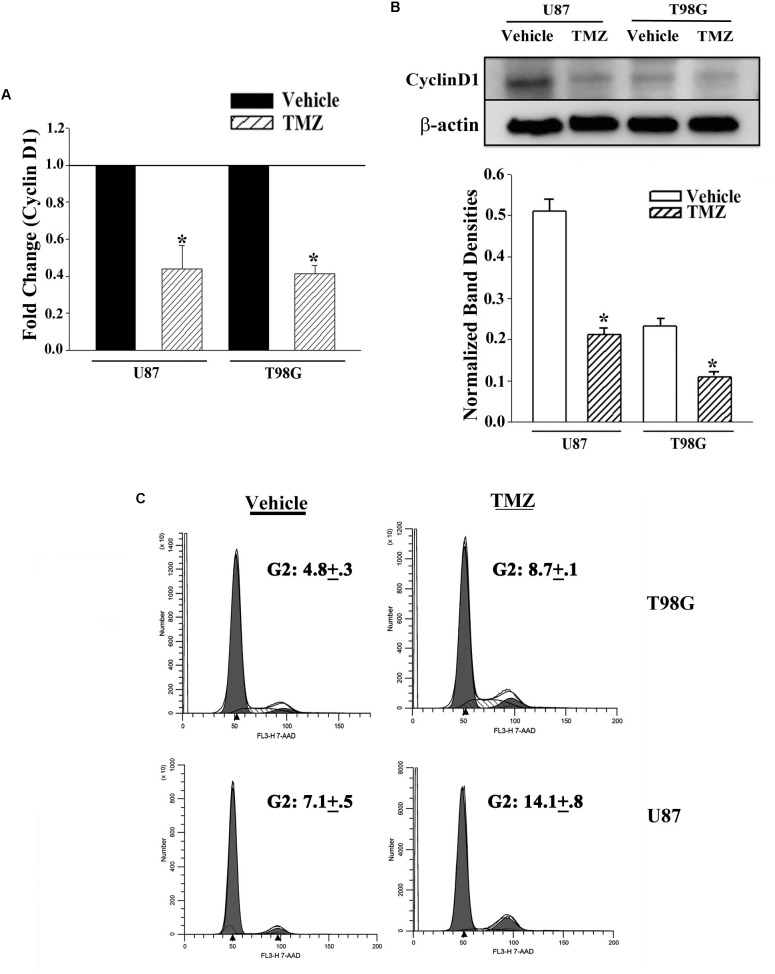
Decrease in Cyclin D1 in TMZ resistant GBM cells and cycling quiescence. (A) Real time PCR was performed with RNA from vehicle- and TMZ-treated U87 and T98G for Cyclin D1 mRNA. The normalized values for vehicle treatment are assigned 1 and the treated cells are presented as fold change (±SD, n = 4). (B) Western blots were performed with cell extracts from vehicle and TMZ-treated U87 and T98G for Cyclin D1. The blot was stripped and reprobed for β-actin. The normalized band densities are presented as the mean ± SD of three different experiments. (C) U87 and T98G cells were labeled with 7-AAD in three independent experiments. The figure shows representative histograms. ∗
p < 0.05 vs. vehicle treatment.